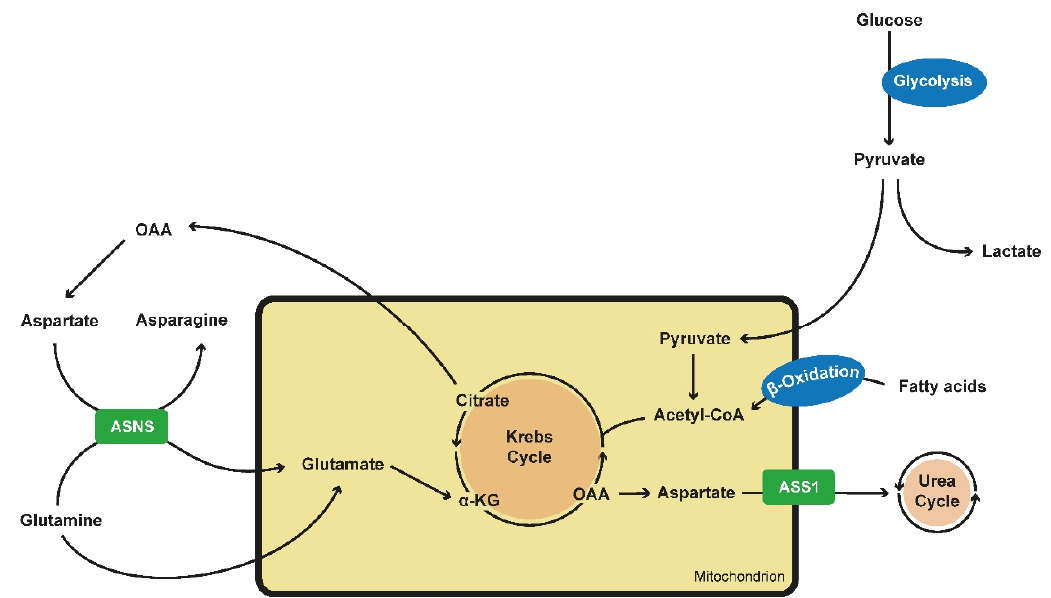
Figure 1. Alterations in metabolics in PKD cells. Glucose is preferably converted into lactate and pyruvate via aerobic glycolysis. As pyruvate is an ine ffi cient fueling for the TCA or Krebs cycle, PKD cells tent to generate building blocks via the use of fatty acids via β -oxidation and the use of the glutamine metabolism. Glutamine is transported into the mitochondrion via ASNS, an enzyme which converts aspartate into asparagine while glutamine is converted into glutamate which itself is located into the mitochondrium. Here it can be fully oxidated and maintain the TCA cycle or it can be carboxylated to produce citrate. Citrate is converted into OAA and acetyl-CoA. OAA itself can generate aspartate, fueling ASNS. ASS1 converts aspartate into arginosuccinate, fueling the urea cycle and being the crucial step of de novo arginine synthesis. ASS1 expression is reduced in PKD cells.